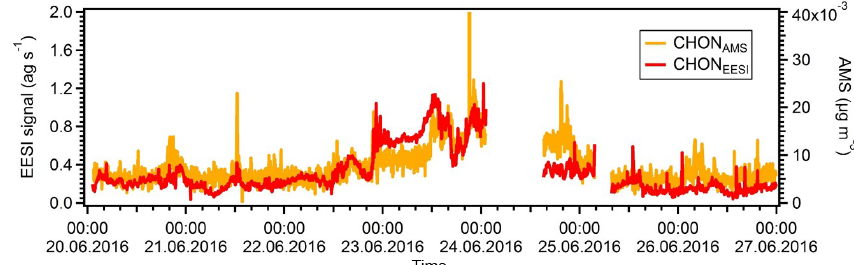
Figure 8. Time series of the total signal of all C x H y O z N p species from the AMS (orange trace) and the EESI-TOF-MS (red